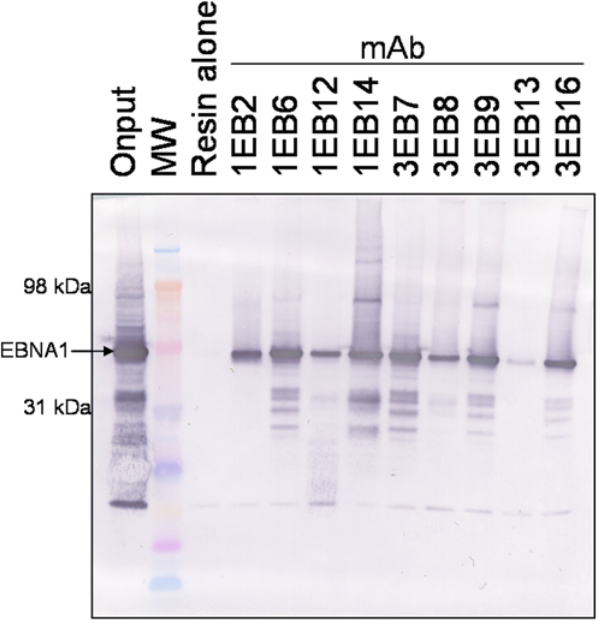
Figure 3. Immunoprecipitation of EBNA1. E. coli -expressed EBNA1 ( , 50 kDa) was isolated from whole cell extract by mixing with equal quantities of mAb-rProteinA-agarose resin. Reactions were allowed to incubate for 1 h, washed to remove nonspecifically bound proteins, and eluted with SDS sample buffer. MW is molecular weight. The Western blot was probed with rat mAb 2B4